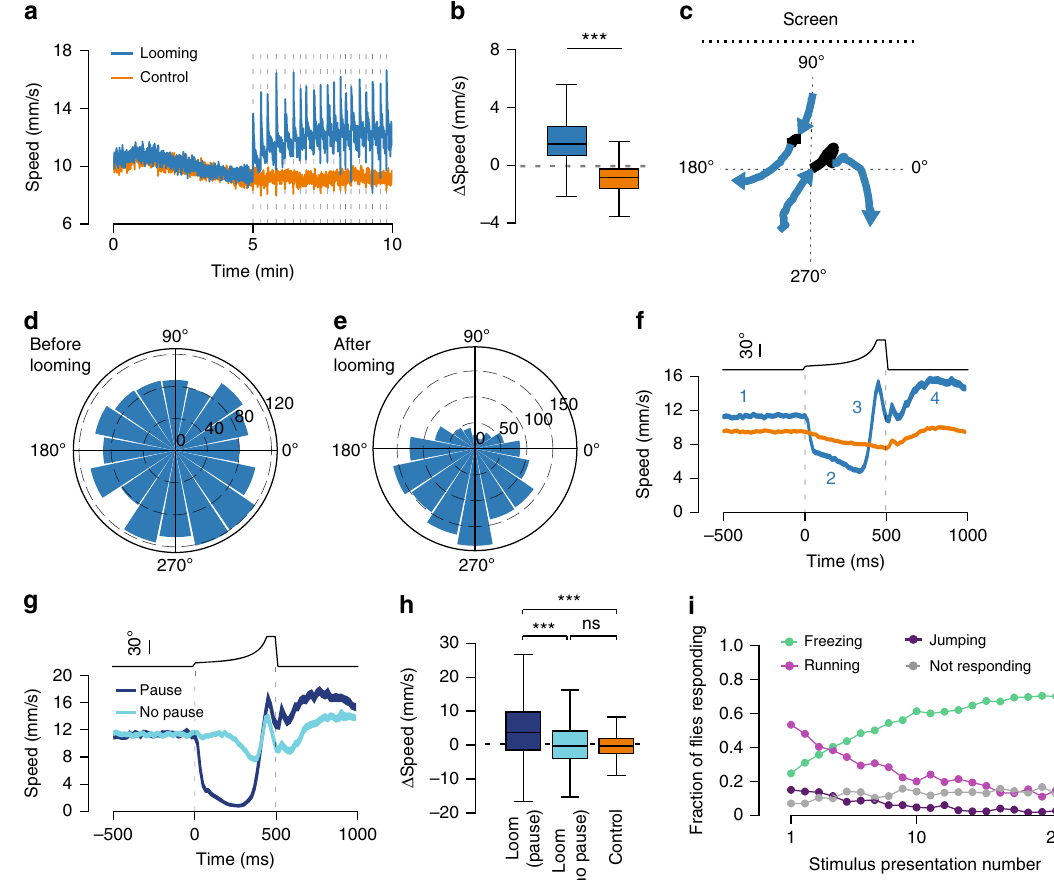
Fig. 3 Flies fl ee to looming stimuli. a Average (±s.e.m.) fl y speed including only time periods classi fi ed as walking. Dashed lines indicate stimulus presentations (in a , b looming n = 280 fl ies, control n = 298 fl ies). b Change in walking speed caused by stimulation (baseline period subtracted